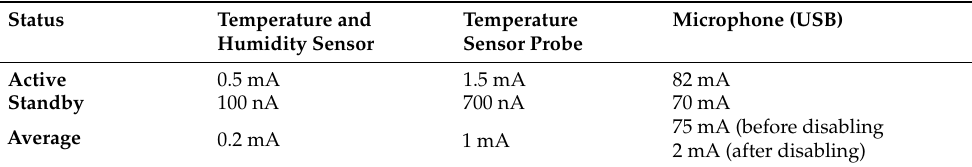
Table 3. Energy consumption of BeeSD end-node device CPU, peripherals, and attached